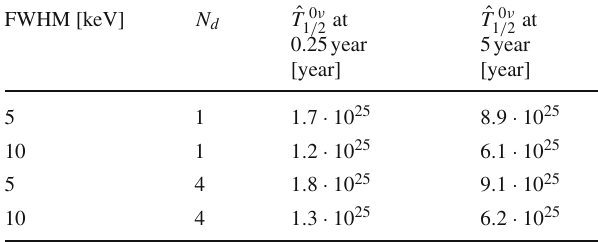
Table 4 Median exclusion sensitivity for different energy resolutions and different subset